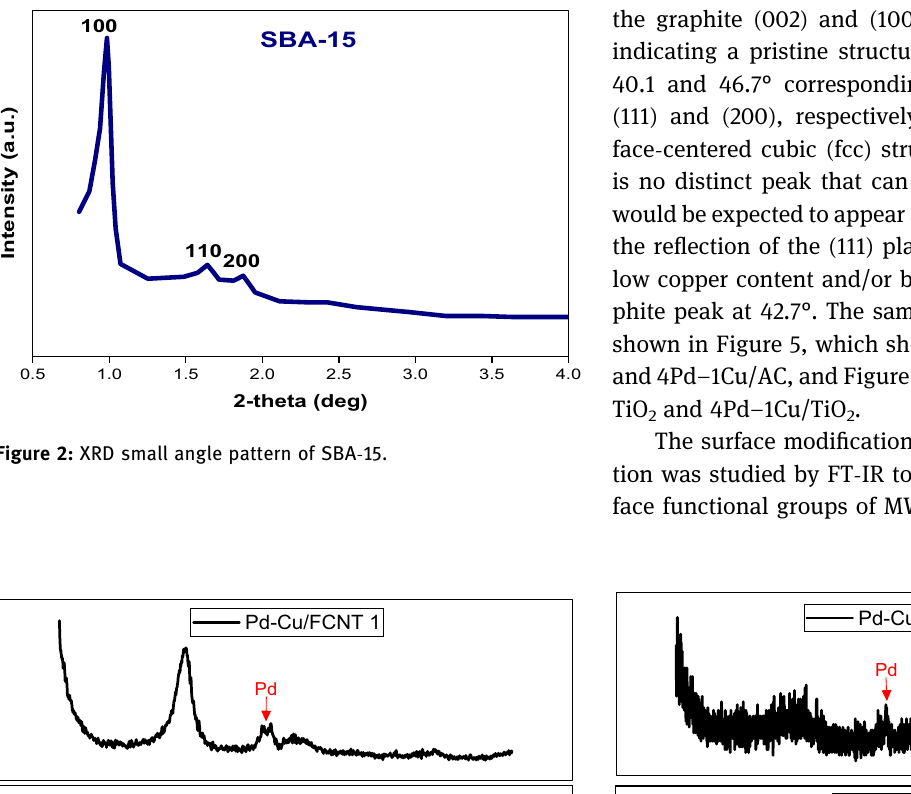
Figuree 5: XRD patterns of AC and 4Pd – 1Cu/AC.